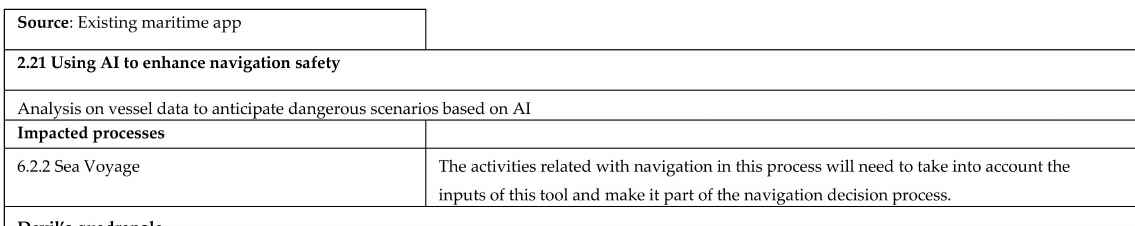
Figure A25. Cont